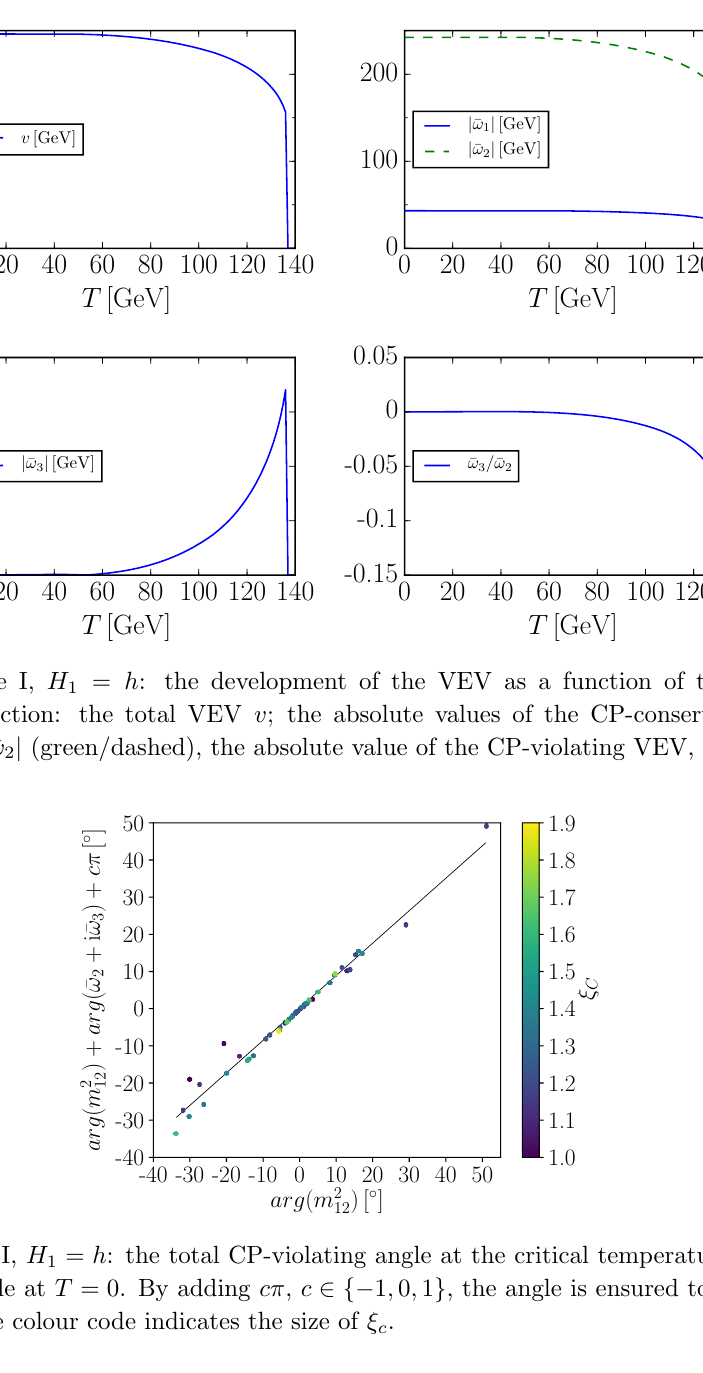
Figure 3 . Type I, H 1 = h : the total CP-violating angle at the critical temperature T c versus the CP-violating angle at T = 0. By adding c(cid:25) , c 1 ; 0 ; 1 , the angle is ensured to lie in the range 2 f(cid:0) g 90 (cid:14) to 90 (cid:14) . The colour code indicates the size of (cid:24) c . (cid:0) CP-violating points (right plot) the number of grey points is reduced. The number